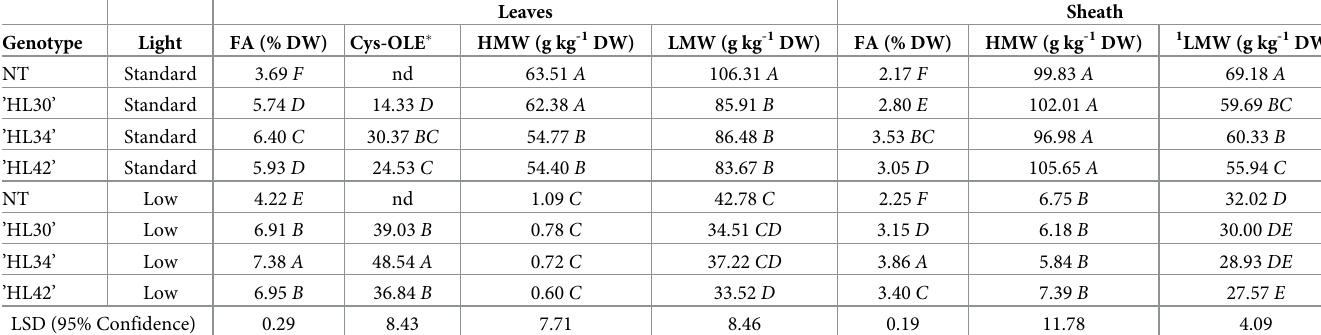
Table 1. Effect of low light on total fatty acid and sugars in high lipid Lolium and control.